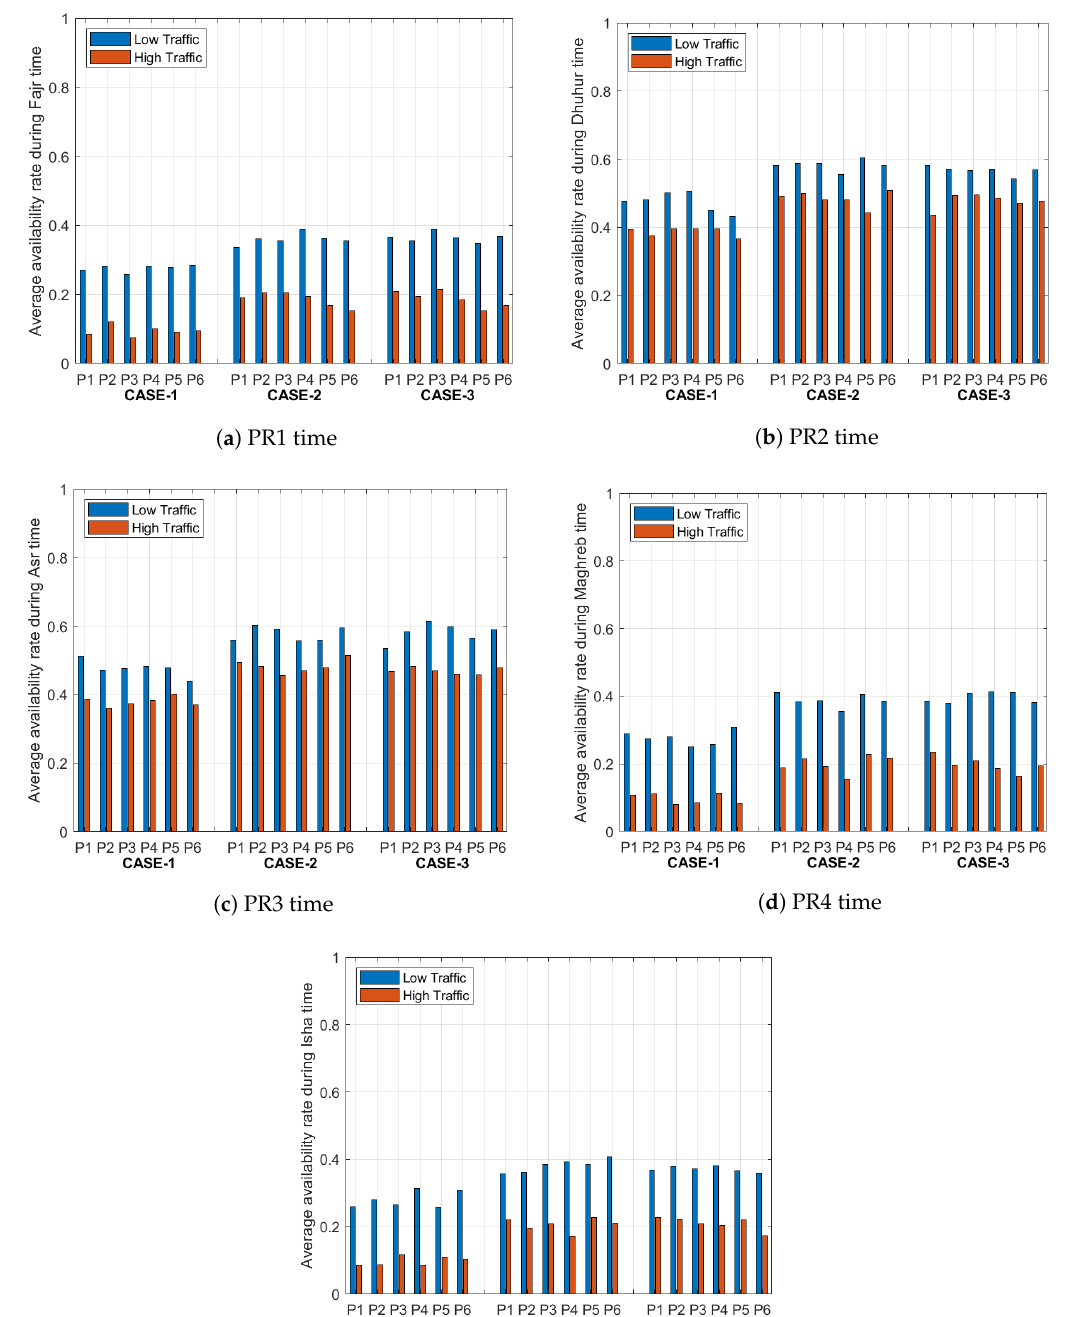
Figure 6. Average availability rates of the six parking lots (P1, P2, P3, P4, P5 and P6) for the five time periods (PR1–PR5). From Figure 6, The availability rate of the parking lots depends on the number of arrivals, where the arrival rate depends on the traffic intensity and the capacity of the parking lot. For low traffic intensities, the availability rate in the parking lot for any